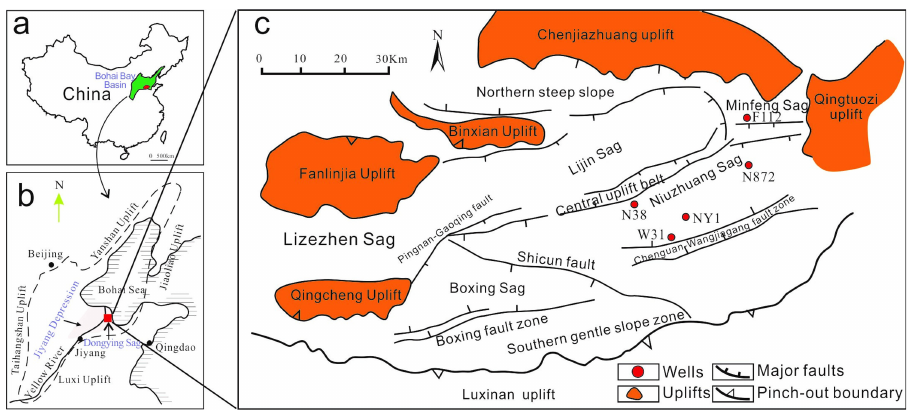
Figure 1. Location map. ( a , b ) Location of the Dongying Sag. ( c ) Structural features of the Dongying Sag and the sampling well locations in the study